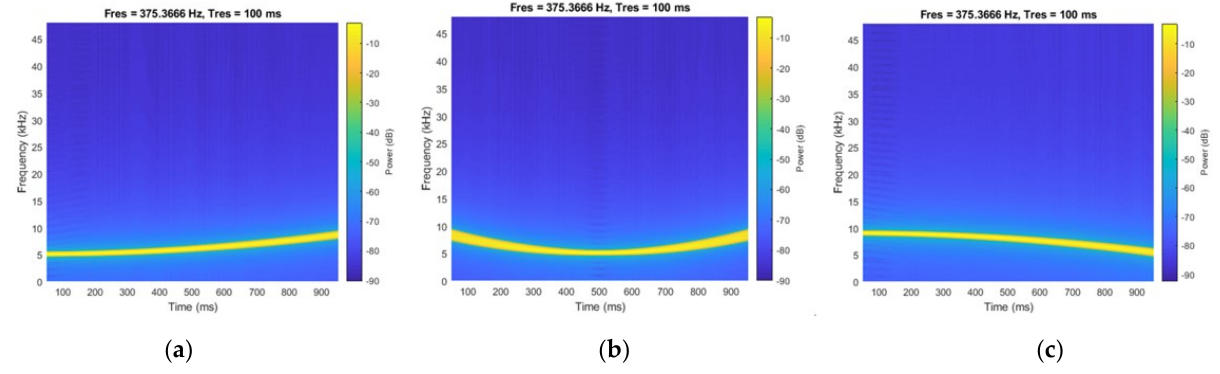
Figure 6. ( a ) Rising frequency; ( b ) U-type; ( c ) decreasing frequency.